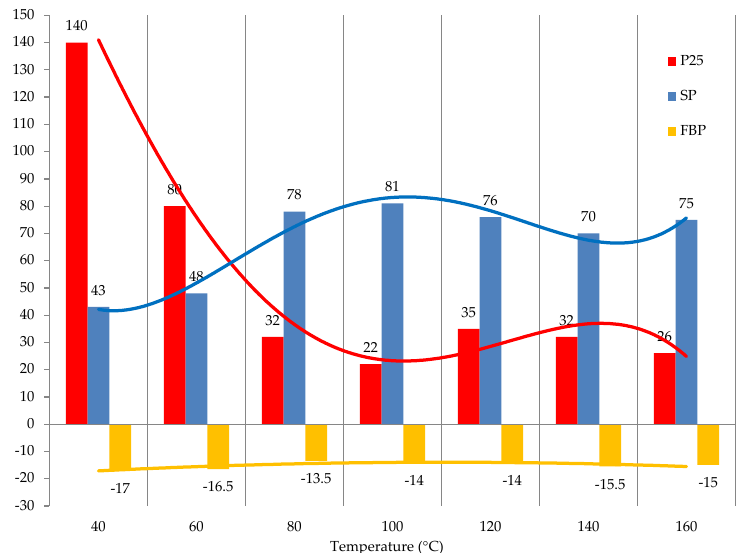
Figure 8. The effect of temperature on the modification process: raw is T1; formalin amount (including formaldehyde) is 10.0 (3.7) kg/100 kg raw; catalyst amount (H 2 SO 4 ) is 2.5 kg/100 kg raw; duration 3 h.